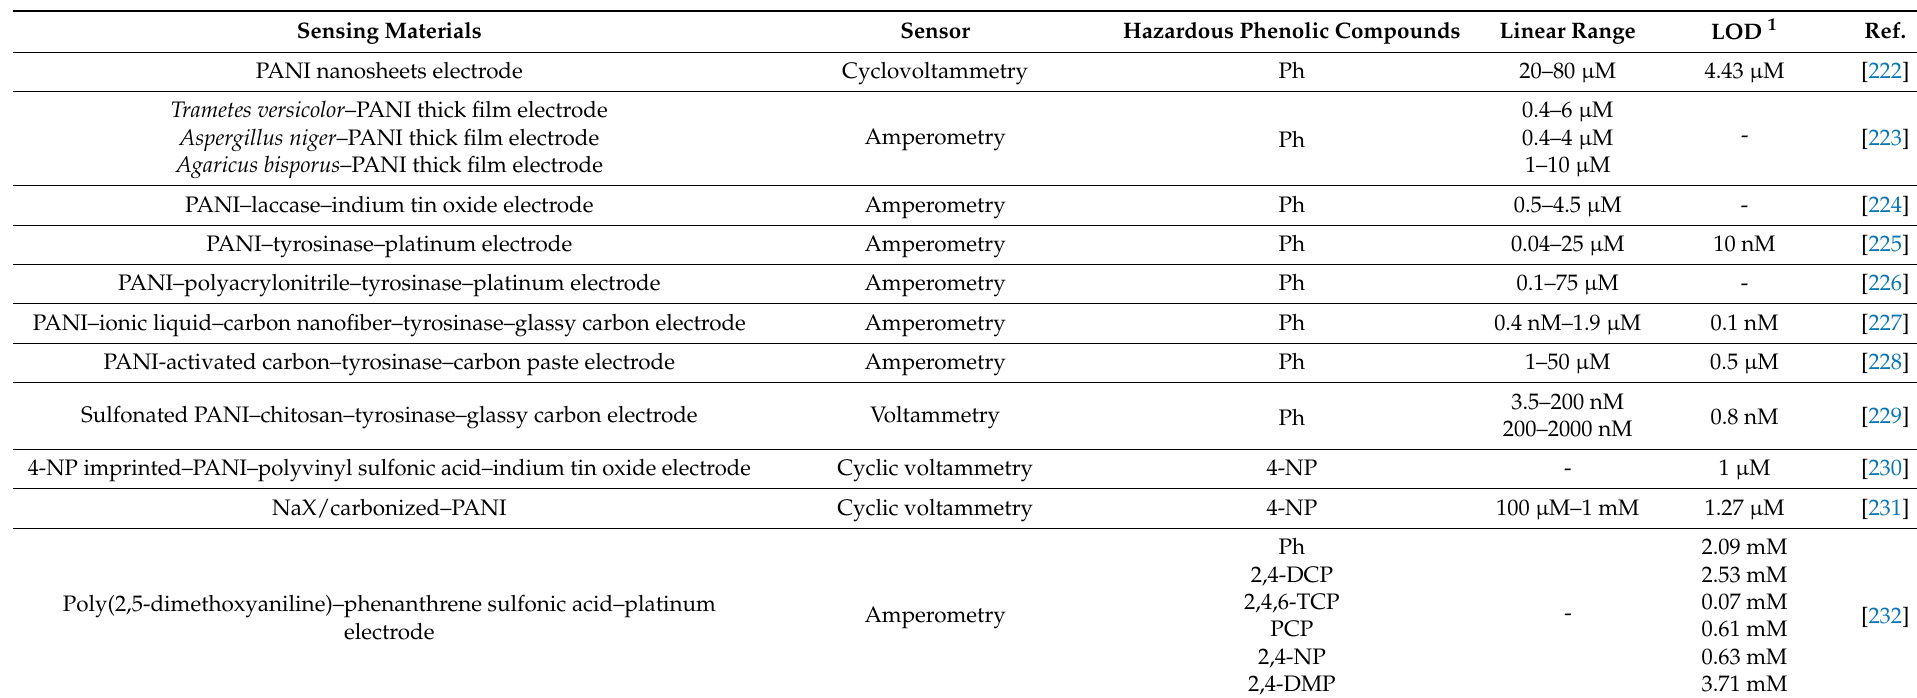
Table 6. PANI and its derivatives-based materials incorporated with electrochemical sensors for hazardous phenolic compounds